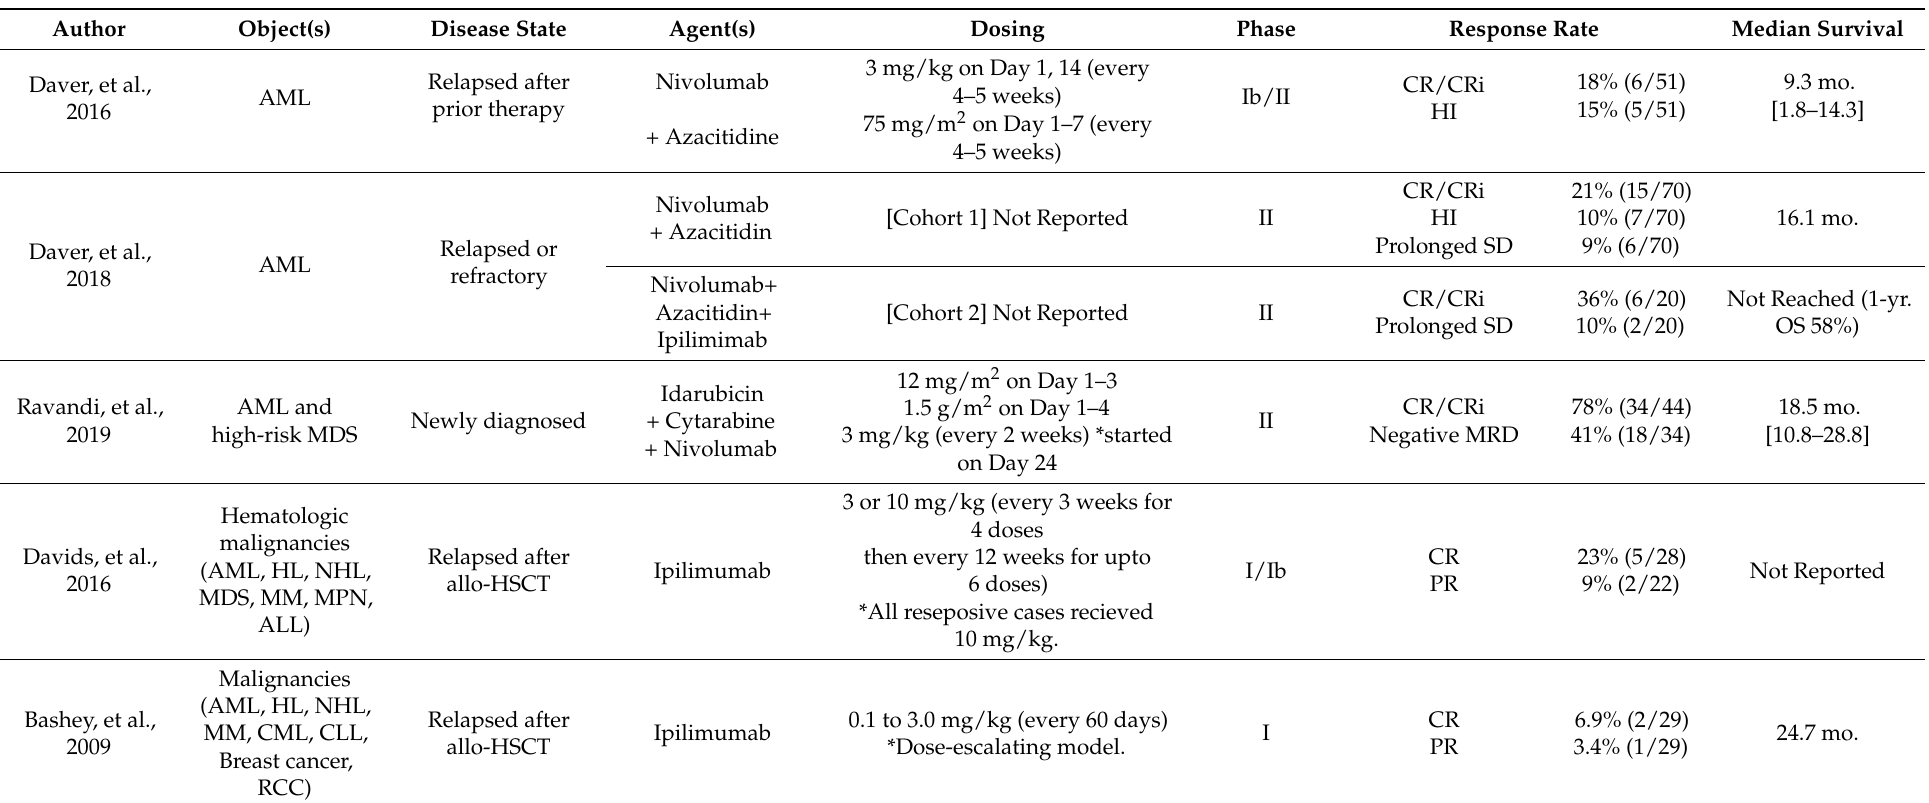
Table 1. A summary of clinical trials of immune checkpoint inhibitors (anti-PD-1, CTLA4, and TIM-3 antibodies) for AML and/or MDS. HL: Hodgkin lymphoma, NHL: non-Hodgkin lymphoma, MM: multiple myeloma, MPN: myeloproliferative neoplasm, ALL: acute lymphoid leukemia, CML: chronic myeloid leukemia, CLL: chronic lymphocytic leukemia, RCC: renal cell carcinoma, allo-HSCT: allogeneic hematopoietic stem cell transplantation, HMA: hypomethylating agent, CR: complete remission, CRi: CR with incomplete hematologic recovery, HI: hematologic improvement, PR: partial remission, SD: stable disease, OS; overall